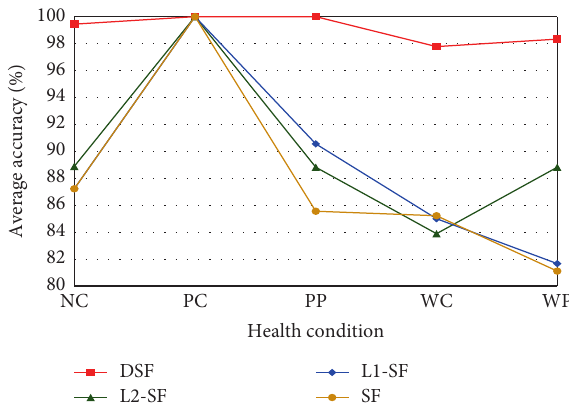
Figure 12: Comparison of average diagnosis accuracies of each health